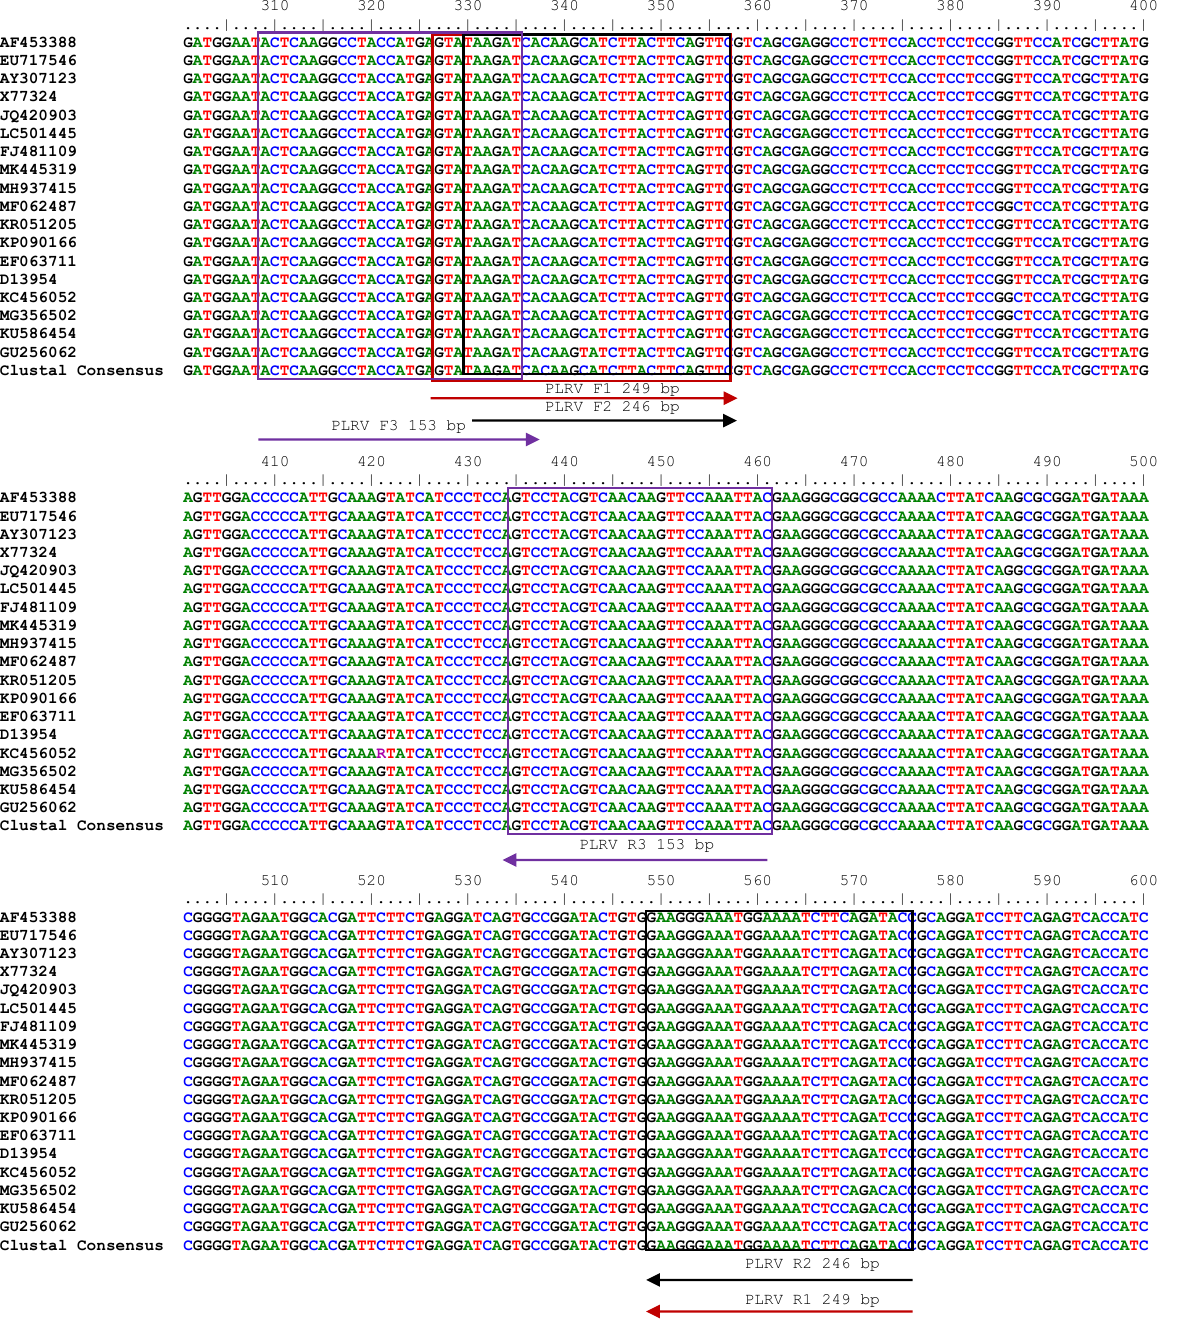
Figure 1. Location of primers in the potato leafroll virus (PLRV) coat protein gene. Free web-based Bio-edit software (https://www.bioinformatics.nl/cgi-bin/primer3plus/primer3plus.cgi/ (accessed on 30 June 2021)) was used to run a ClustalW multiple sequence alignment. The present study fol- lowed the manufacturer ’s instructions, and primers in triplicate were generated using a full-coat protein gene by specifically targeting conserved regions. NCBI ’ s GenBank database (http://www.ncbi.nlm.nih.gov/blast (accessed on 30 June 2021)) provided the sequences (Accessions AF453388, EU717546, AY307123, X77324, JQ420903, LC501445, FJ481109, MK445319, MH937415, MF062487, KR051205, KP090166, EF063711, D13954, KC456052, MG356502, KU586454 and GU256062). The boxes denote primer regions, while arrows have been placed to specify the primer positions for reverse transcription-recombinase polymerase amplification (RT-RPA).